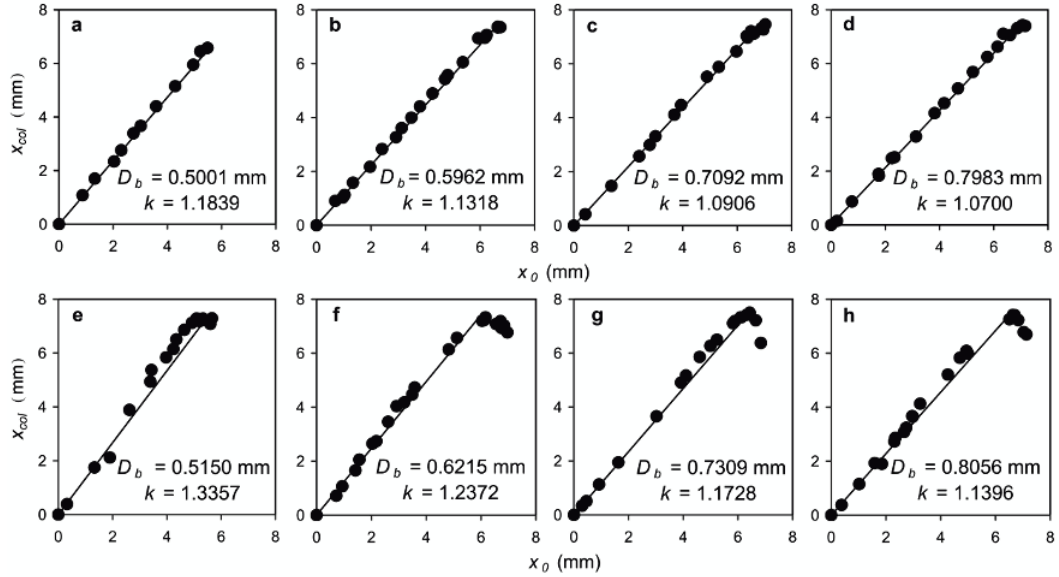
Fig. 3. Observed dependence of the radial distance x col at the time of collision with the particle, on the initial position x 0 of the bubble. Data for pure water, particle velocity 50 mm / s (a-d) and 100 mm / s (e-h).